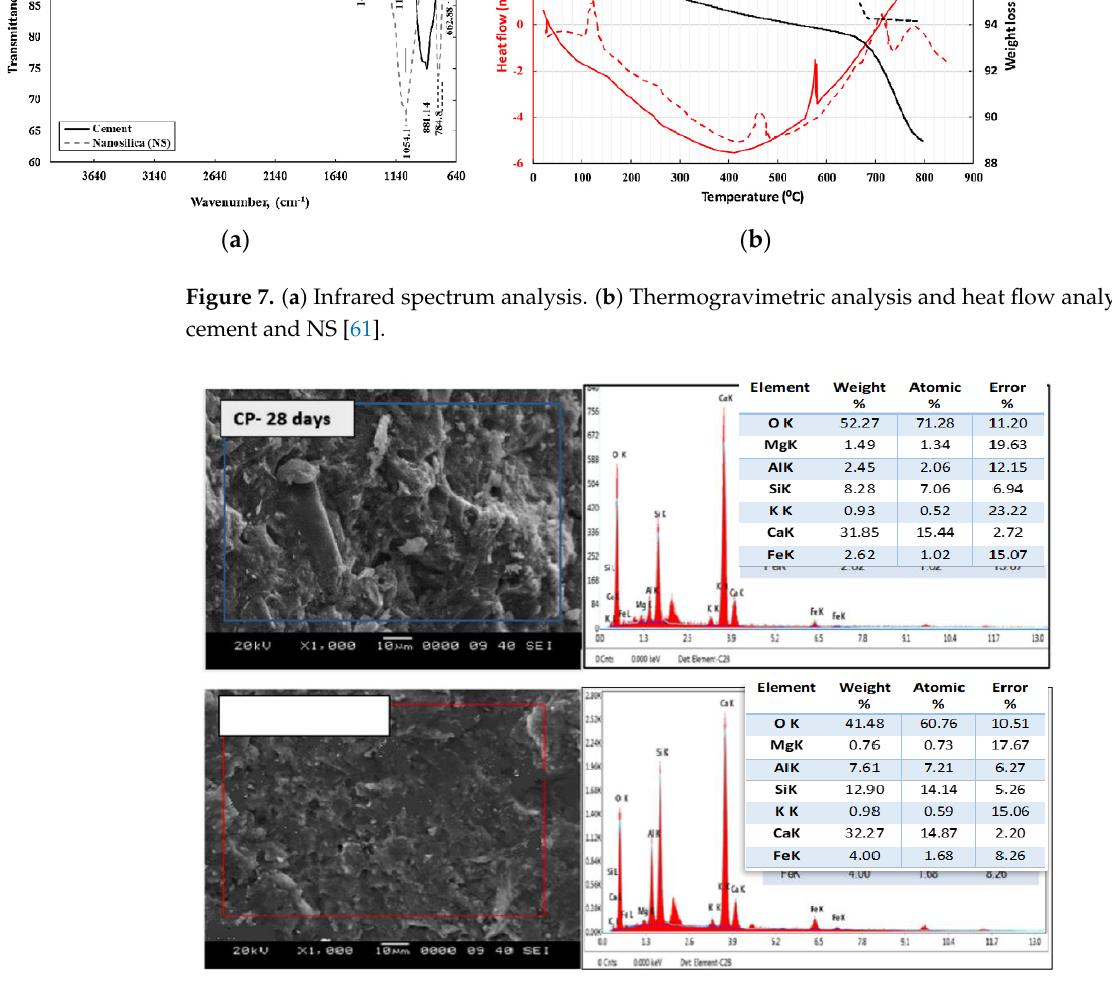
Figure 8. SEM-EDX analysis of control sample and 3% NS content [62].